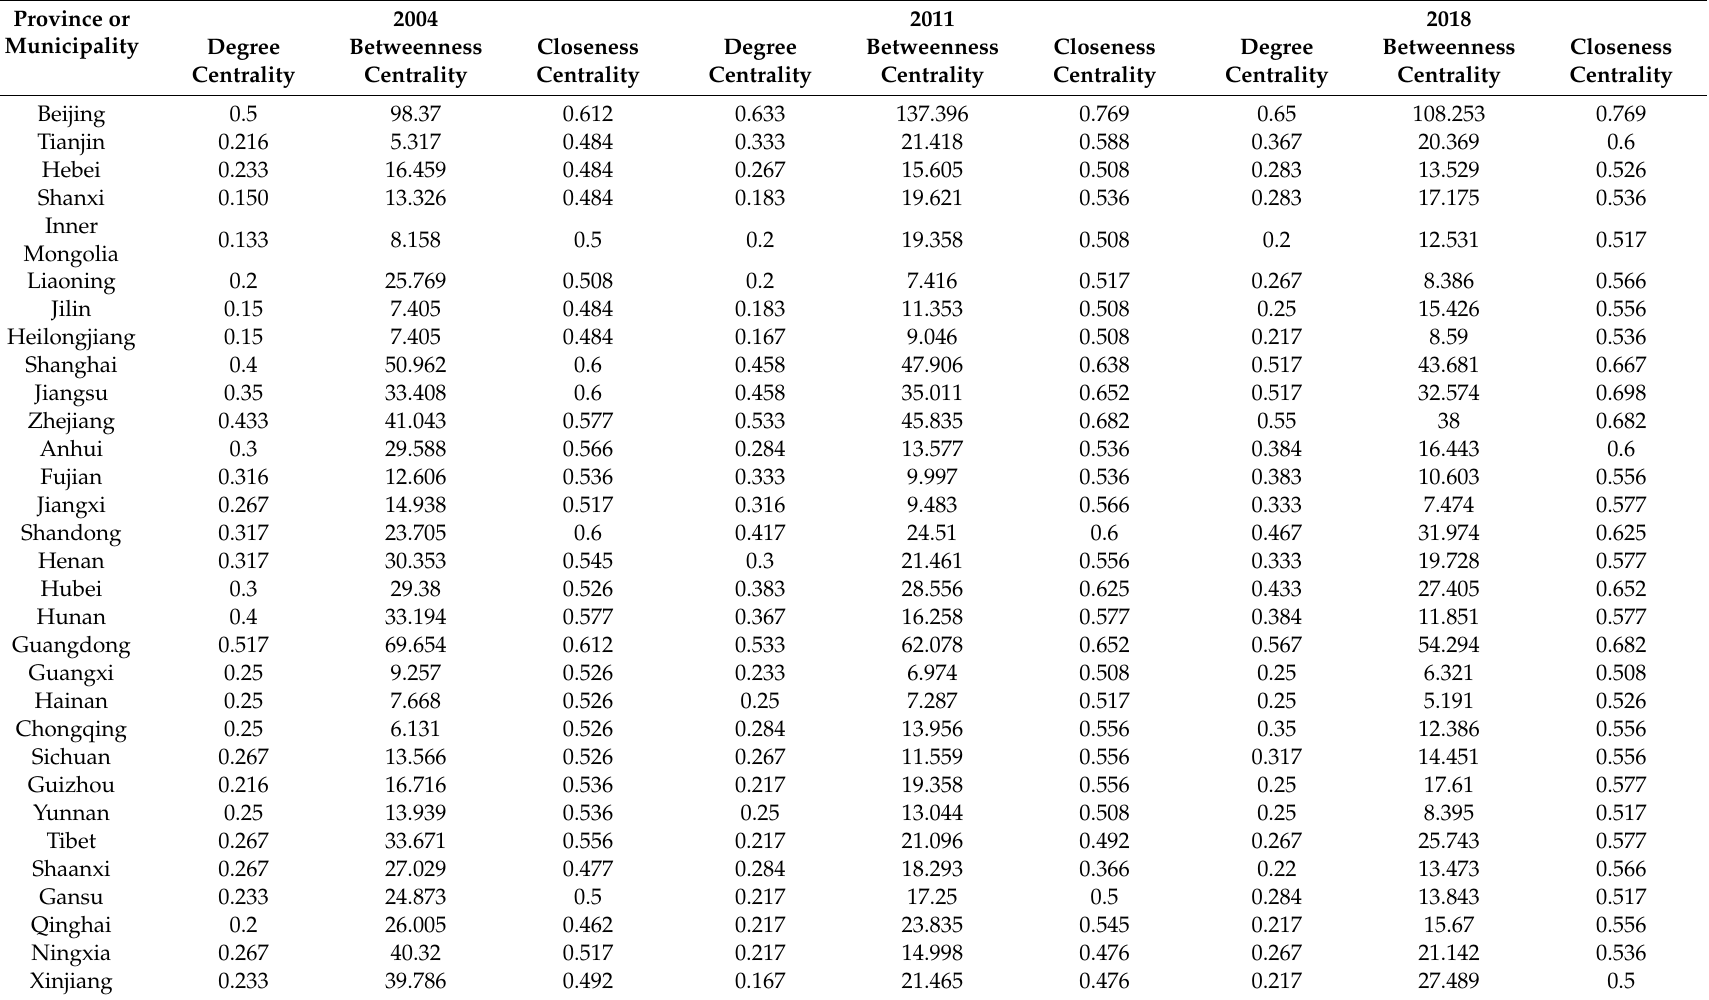
Table 2. Centrality of the spatial correlation network of health resource agglomeration capacities in